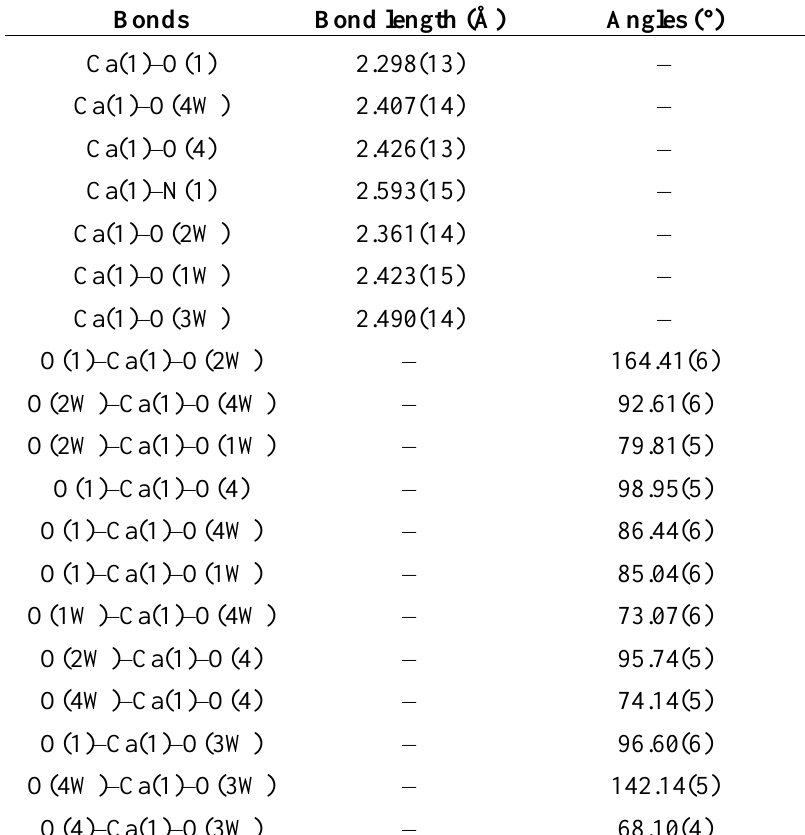
Table 3. Selected bond lengths (Å) and angles (°) for Ca(II) coordination